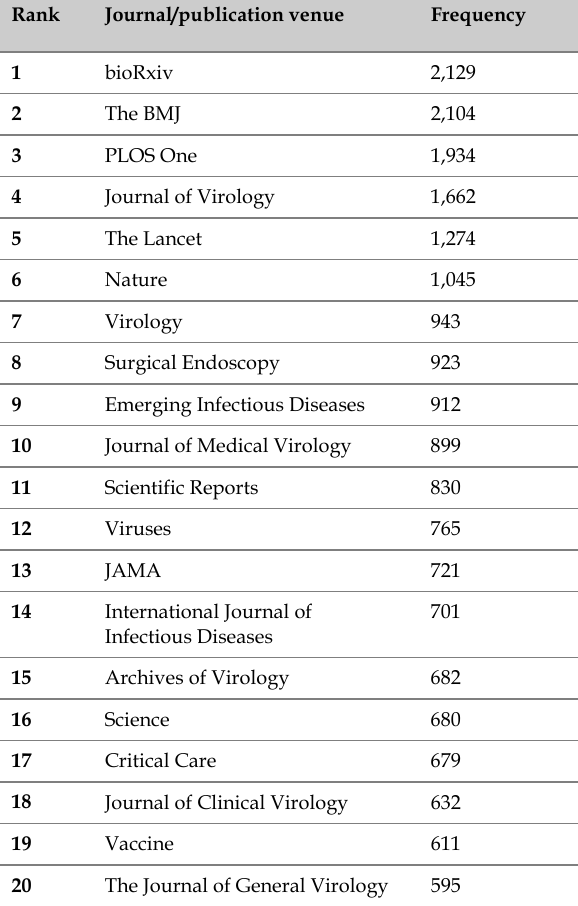
Table 2 The top 20 publication venues for COVID-19-related research